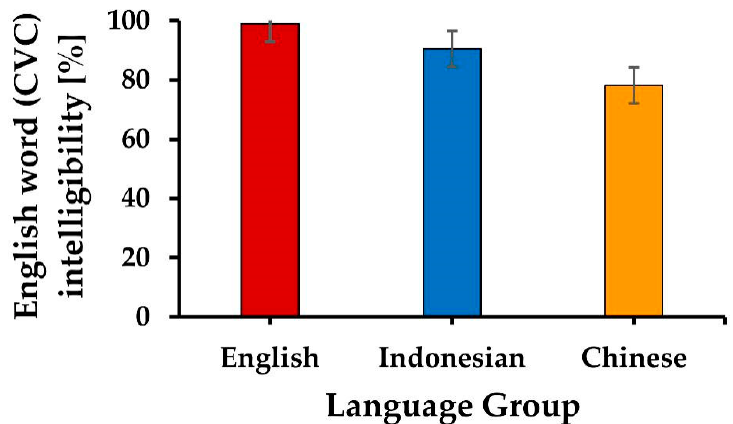
Figure 2. Word identification accuracy (intelligibility) for original speech for each language group (English, n = 19; Indonesian, n = 19; Chinese, n = 20). Error bars indicate standard error of means.